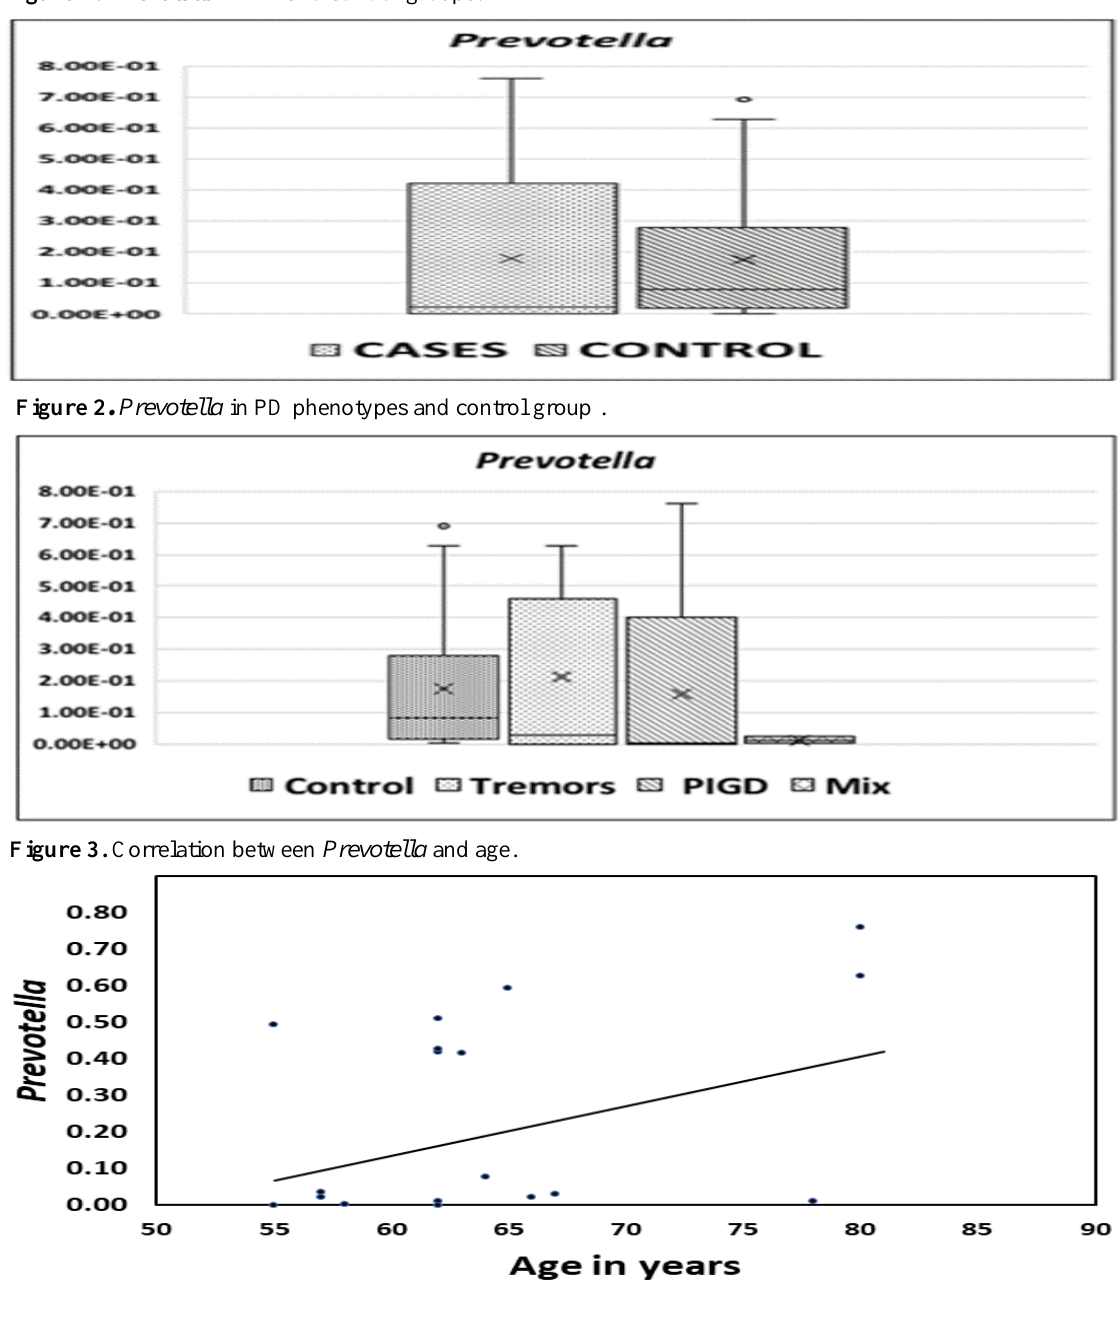
Figure 1. Prevotella in PD and control groups.